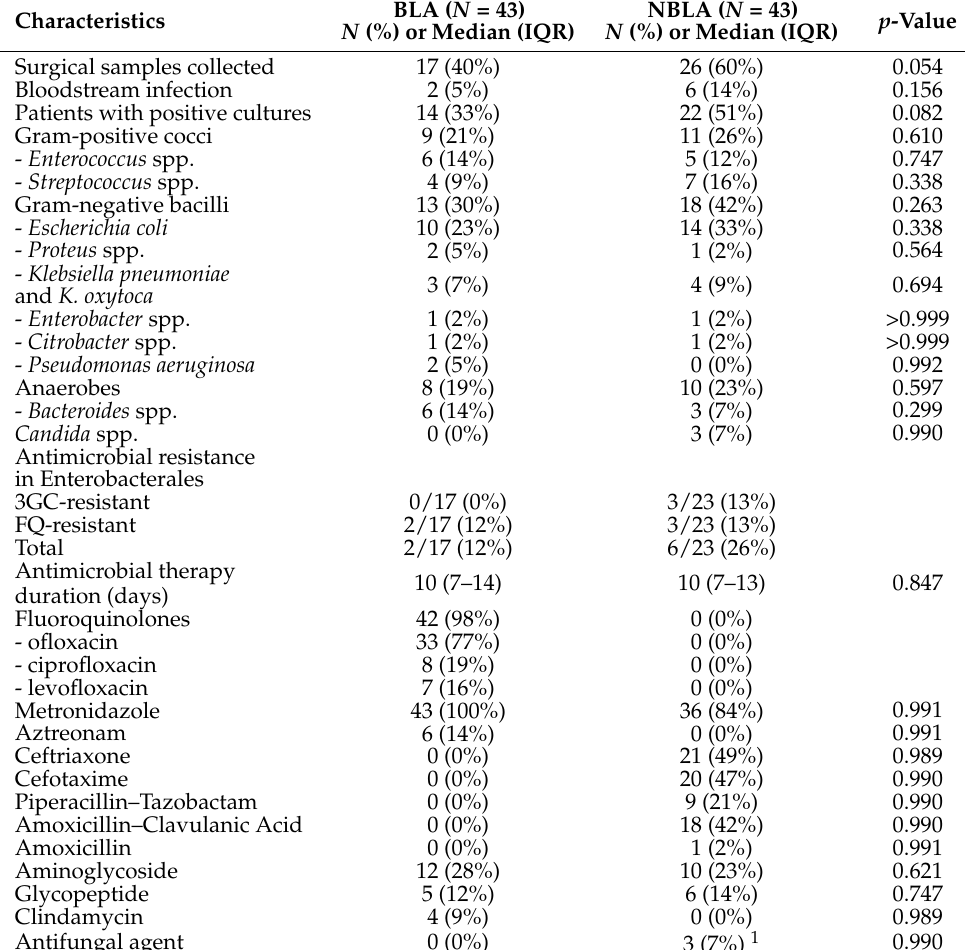
Table 2. Documented cultures, antibiotic resistance, and antibiotics administered.